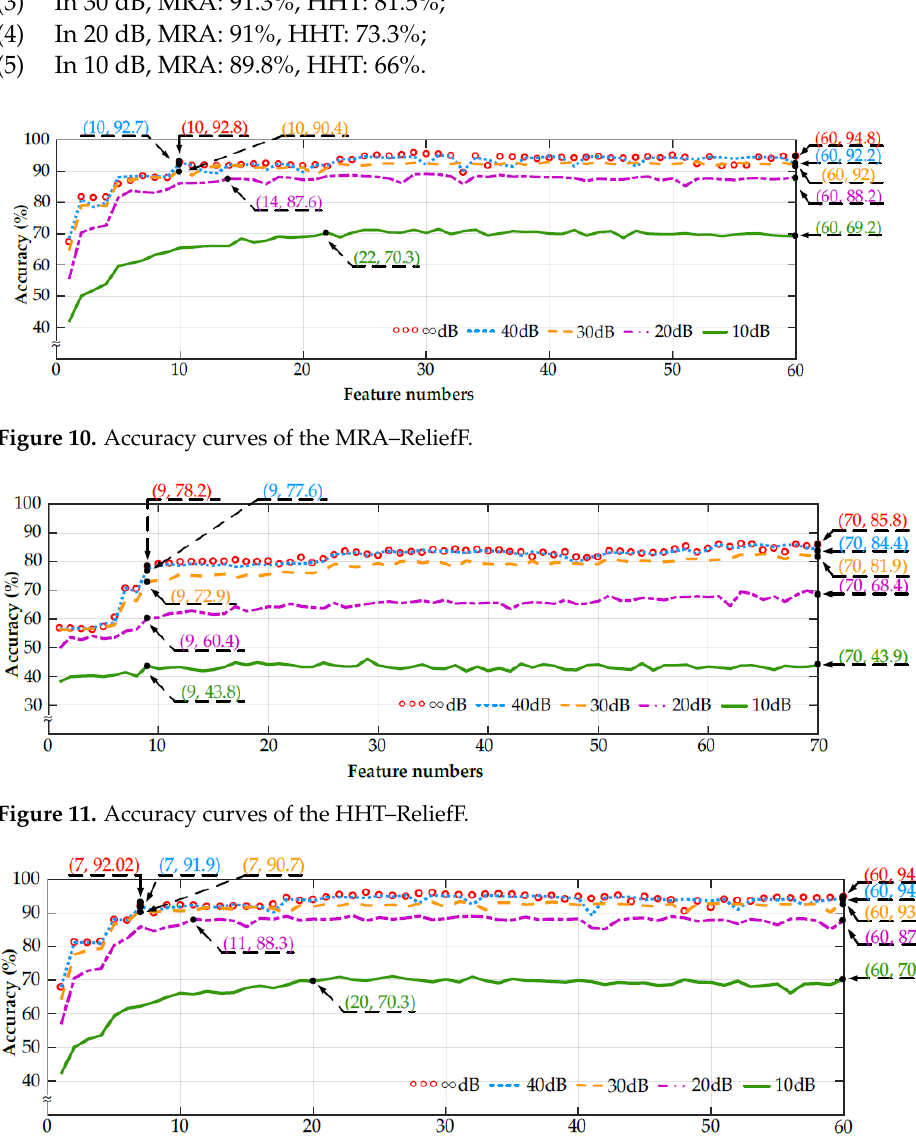
Figure 12. Accuracy curves of the MRA–CFS.